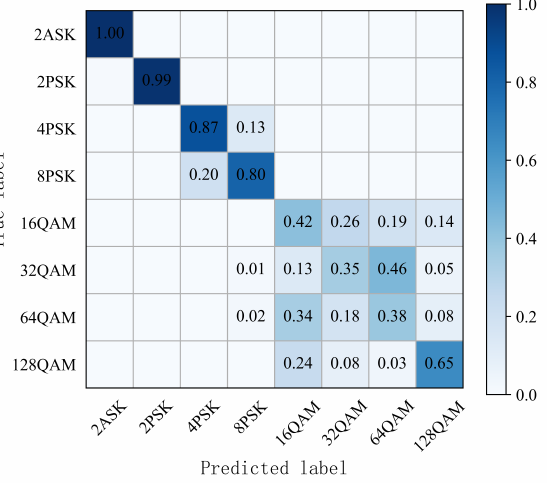
Figure 9. Confusion matrix for different modulated signals at a frequency offset of 50 kHz when the SNR is − 5